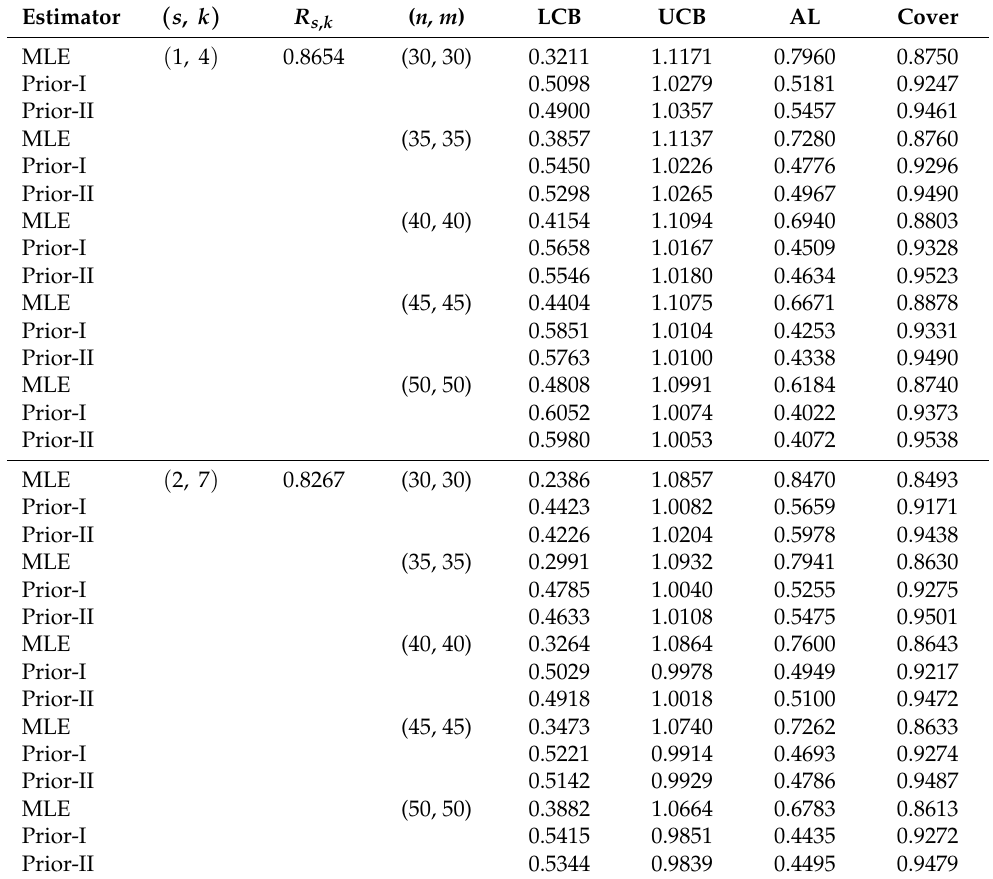
Table 7. The 95% confidence intervals of R s , k for Case 2, ( α , λ 1 , β , λ 2 ) = ( 1.5, 1, 2, 1 ) , and T =